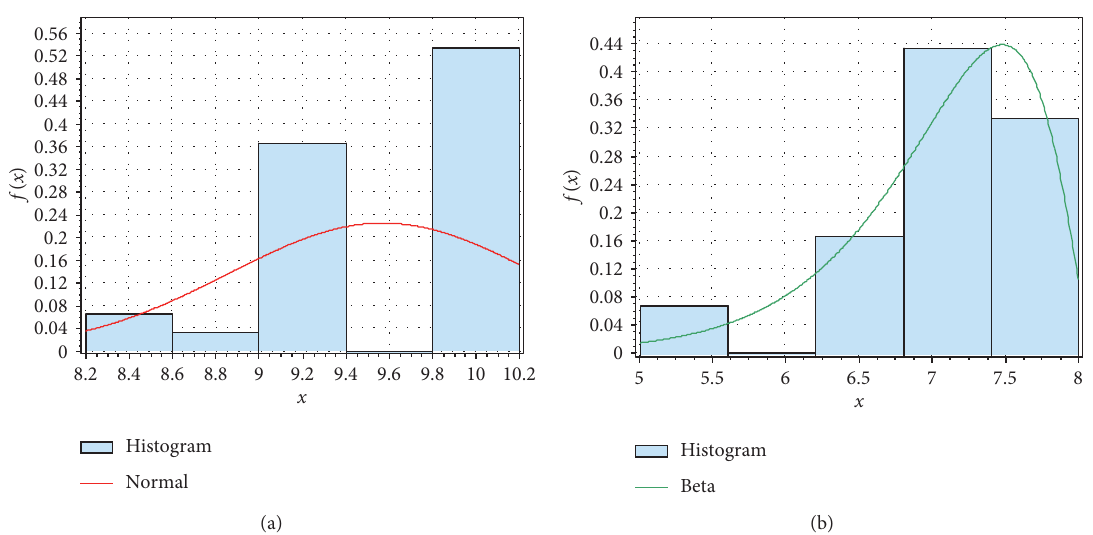
Figure 10: Histogram and distribution fitting. (a) Total profit ($) and (b) route length